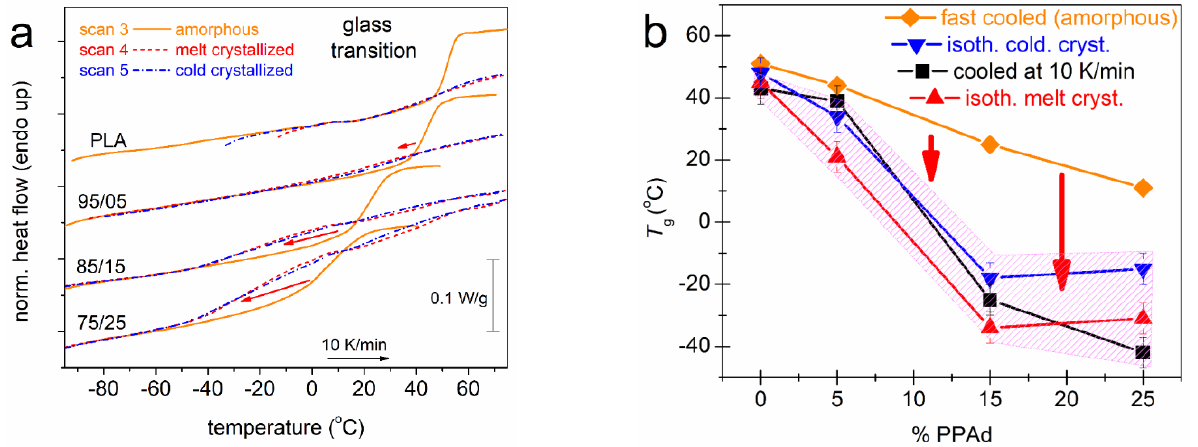
Figure 8. ( a ) Comparative DSC traces during heating showing the glass transition for all samples along with the changes imposed from the amorphous to the semicrystalline state (marked by the added arrows). ( b ) The PPAd fraction dependence of the glass transition temperatures, as recorded during heating by the various thermal treatments. The shaded area includes all the cases of semicrystalline polymers. The added vertical arrows mark the effects imposed on ‘amorphous state’ T g by the implementation of crystallization.